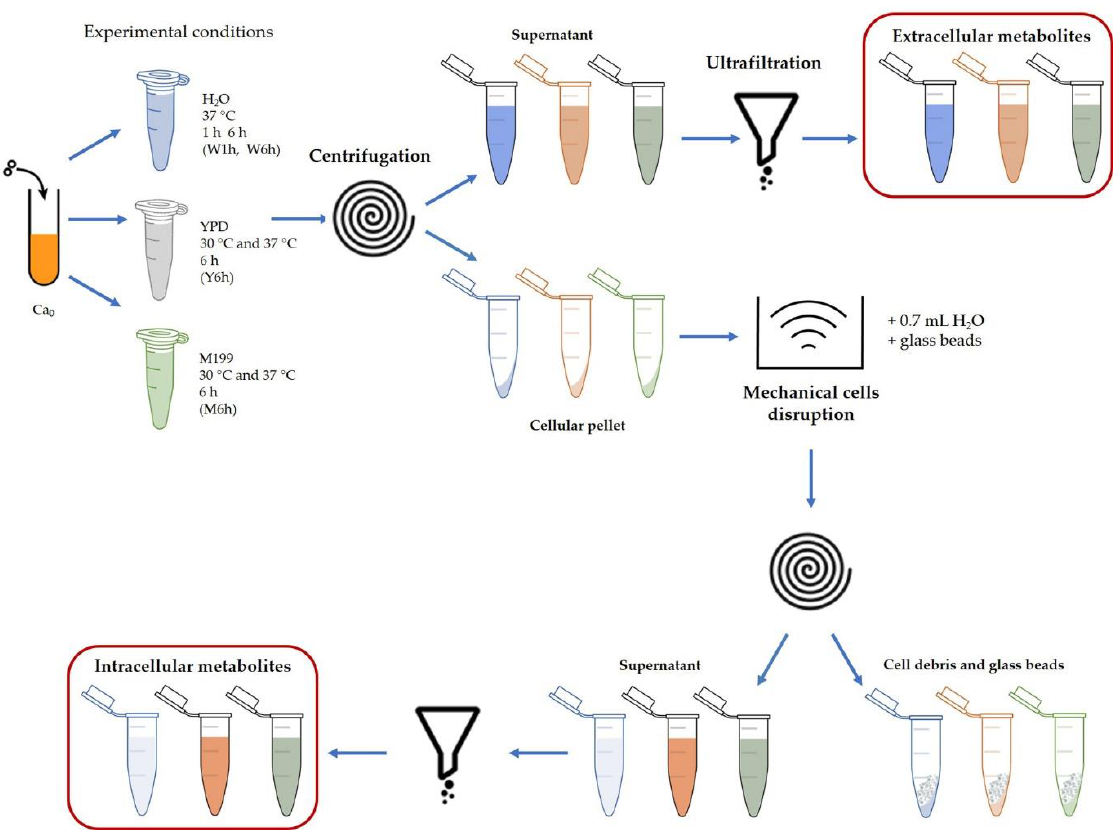
Figure 1. Outline of the sample preparation protocol, designed to collect a set of extracellular and intracellular metabolites (red boxes) for each experimental condition. To obtain a hypoxic environment, incubation was carried out in closed tubes. Intracellular metabolites were also produced from the initial reference culture Ca 0 . W1h and W6h, cells suspension in water at 1 h and 6 h (37 °C); Y6h, YPD culture at 6 h (30 °C and 37 °C); M6h, M199 culture at 6 h (30 °C and 37 °C). Extracellular metabolites: cells suspended in water or cultured in YPD and M199 media were centrifuged at 12,000× g for 5 min at 4 °C. The supernatants were protein depleted by ultrafiltration at 4000× g for 30 min at 4 °C (Amicon Ultra-2 Centrifugal Filter Unit, membrane cut-off 10 kDa, Merck KGaA, Darmstadt, Germany). YPD and M199 fresh media were ultrafiltered at 4000× g for 30 min at 4 °C to be used as reference.